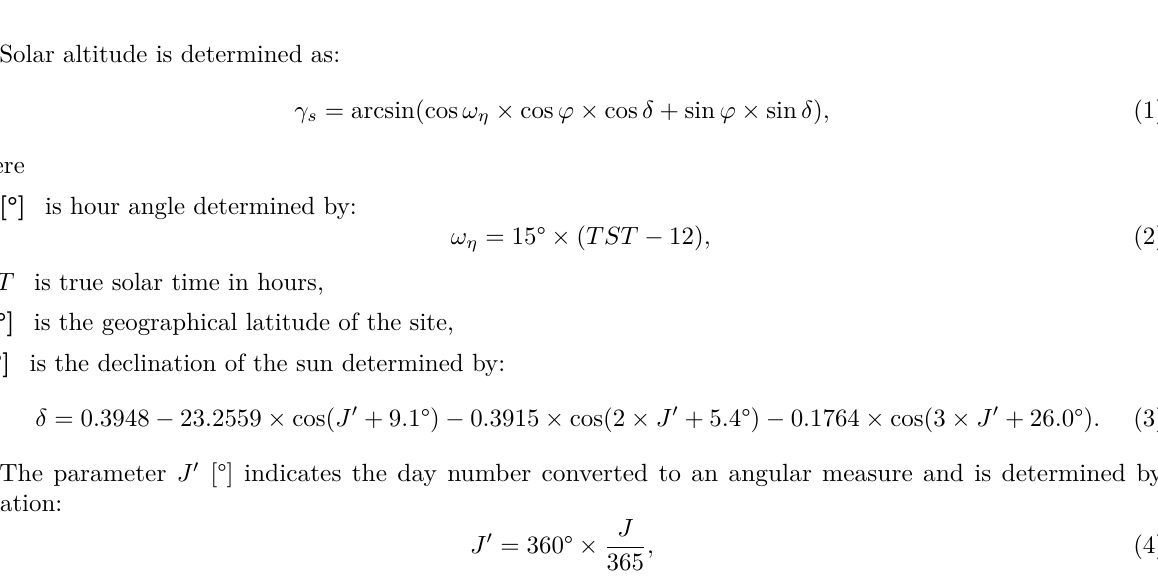
Figure 1. Minimum solar altitude in accordance with EN 17037 [5] ( h the window, h h is height of the window head).